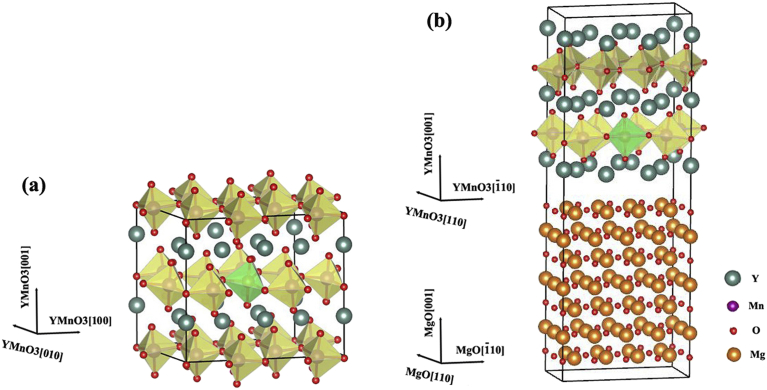
Schematic of the computational cell considered for (a) the hexagonal YMn0.917TM0.083O3 (TM = Ti ∼ Zn) bulk and (b) the YMn0.917TM0.083O3(001)/MgO(001) (TM = Ti, V, Cr and Fe) film configurations, where pine green, purple, red and orange spheres indicate Y, Mn, O and Mg atoms, respectively. On the MnO layer, each Mn atom is surrounded by bipyramidal oxygen atoms which form a MnO5 trigonal bipyramid (light yellow). The Mn atom in the green bipyramid will be substituted by a TM atom in the work.